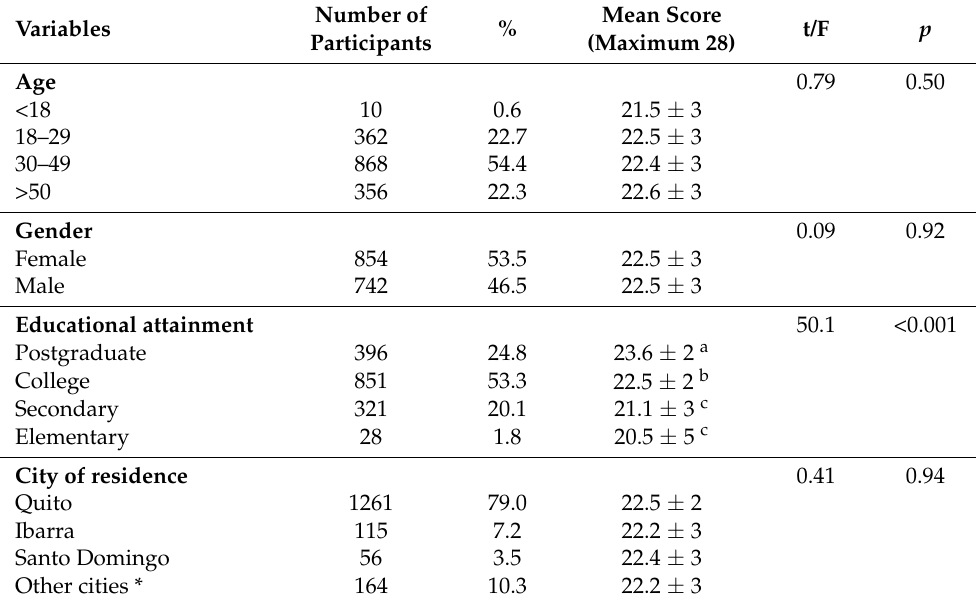
Table 1. Demographic characteristics of participants and scores by demographic